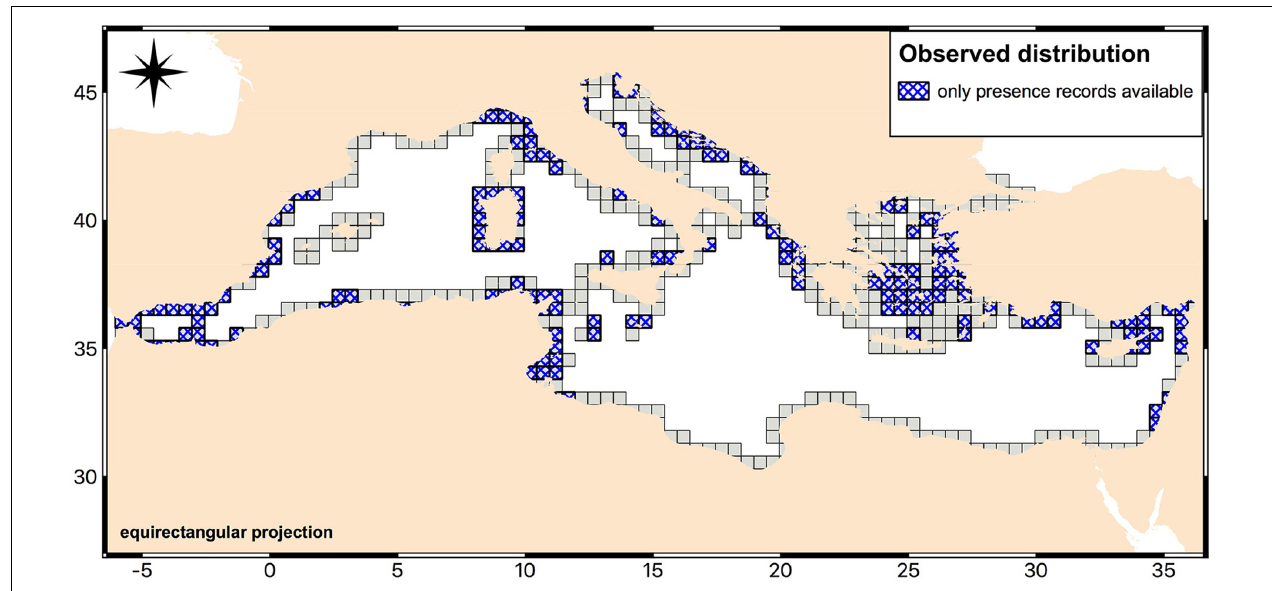
FIGURE 5 | Observed distribution of Cystoseira records used in the model validation. The map shows the areas where only presence information was available. Map created with QGIS software (QGIS Development Team, 2018. QGIS Geographic Information System. O3.Open Source Geospatial Foundation: https://www.qgis.org/